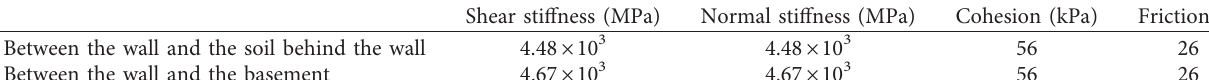
Table 3: Material parameters of the interface.